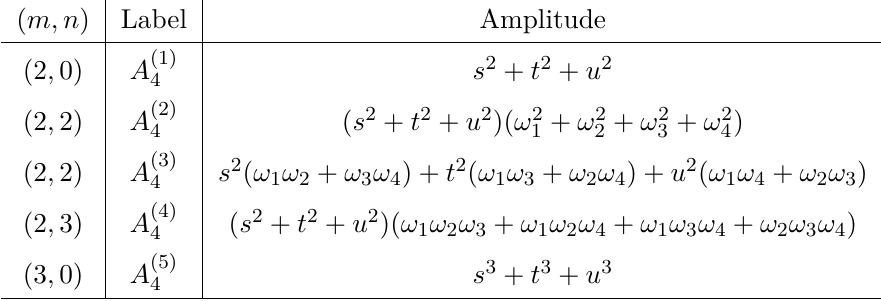
Table 2 . Seed four-point amplitudes in type A 1 theories with 2 m + n < 8 and the soft scaling parameter σ ≥ 2 . Here s, t, u are the usual relativistic Mandelstam variables, whereas ω i are the energies of the participating